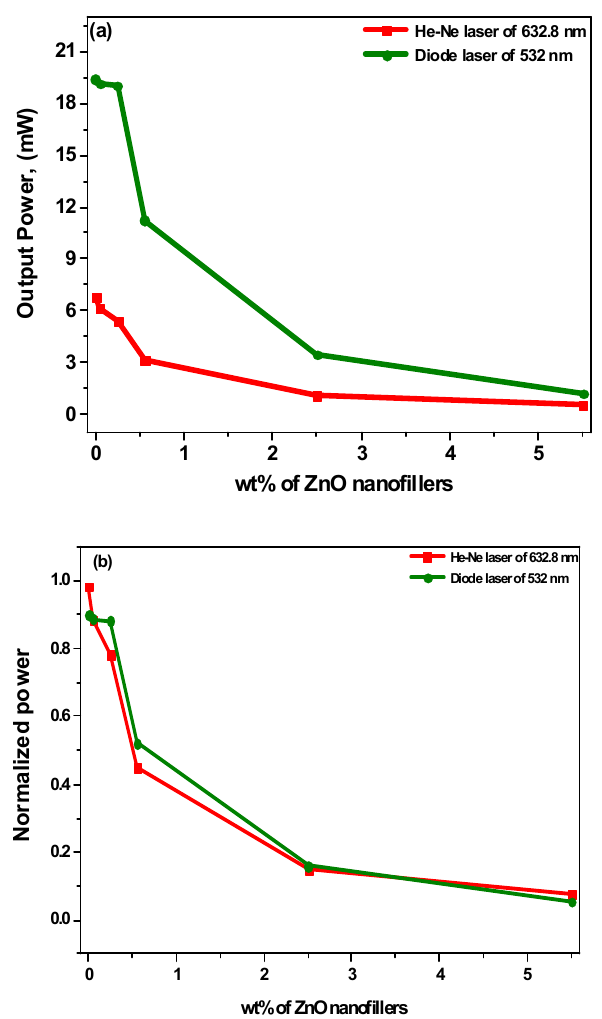
Figure 8. ( a , b ): ( a ) Output power, ( b ) Normalized power to study the optical limiting effects using two excitation sources: He-Ne laser at 638.2 nm and diode laser at 532 nm for PB ZnO nanocomposite films .